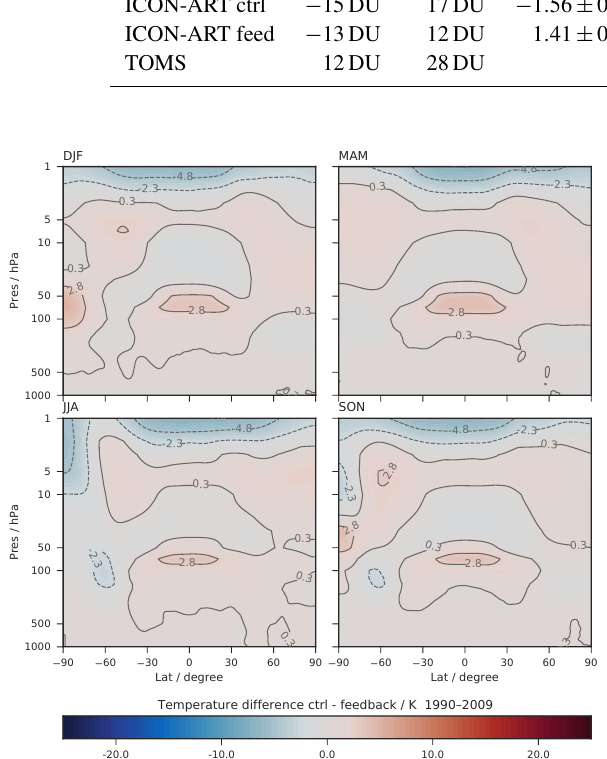
Figure 9. Latitude–height cross sections of seasonal and zonal mean temperature differences (K) for control minus feedback sim- ulation, as shown in Fig. 8.